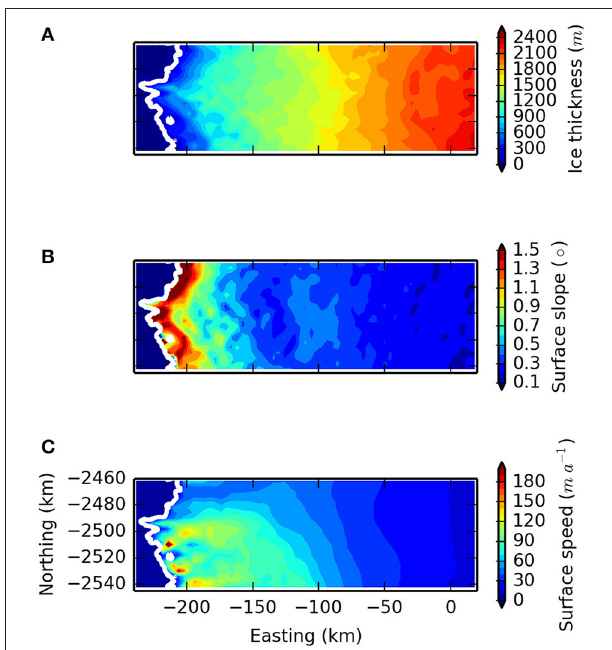
FIGURE 5 | Ice thickness (A), surface slope (B), and surface speed (C) fields used for the force balance calculations after pre-processing as described in the text.